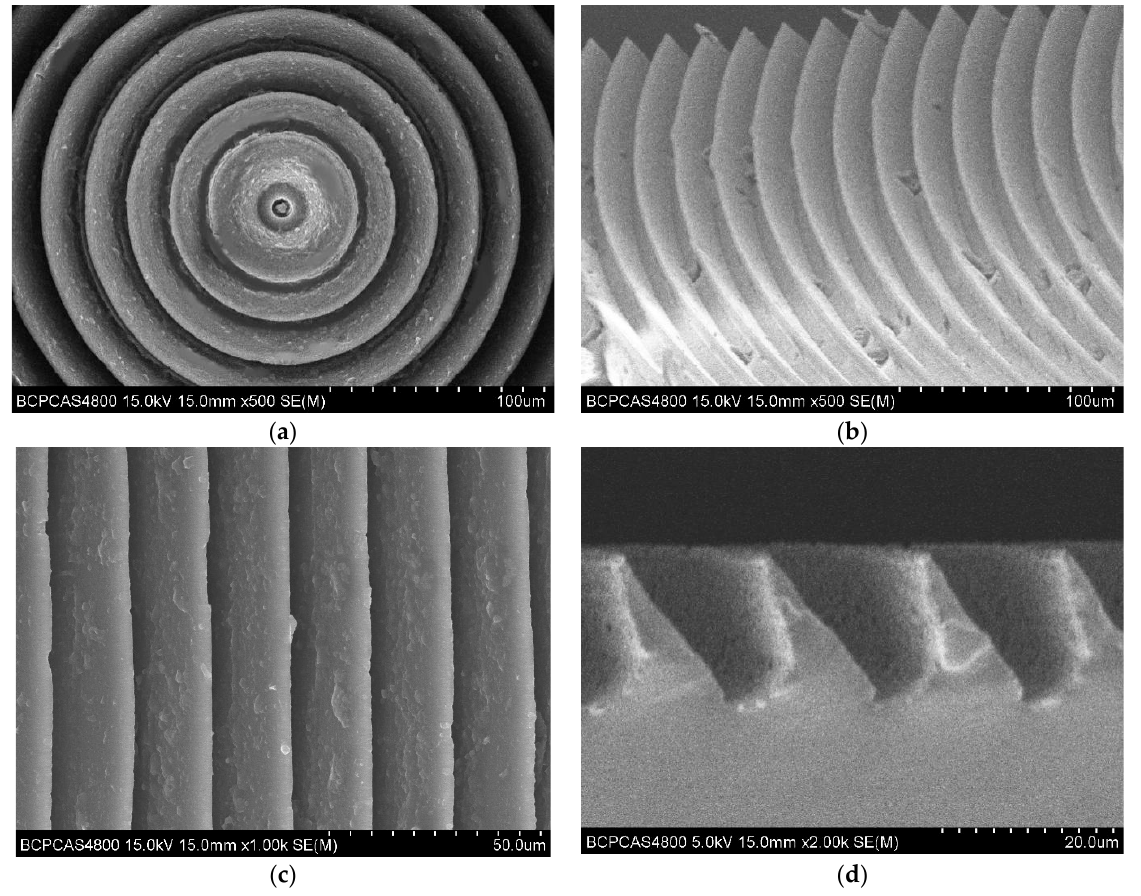
Figure 13. SEM image of PDMS material with microstructure. ( a ) Overall outline; ( b ) partial out- line; ( c ) top view; ( d ) side view. ( c ) top view; ( d ) side